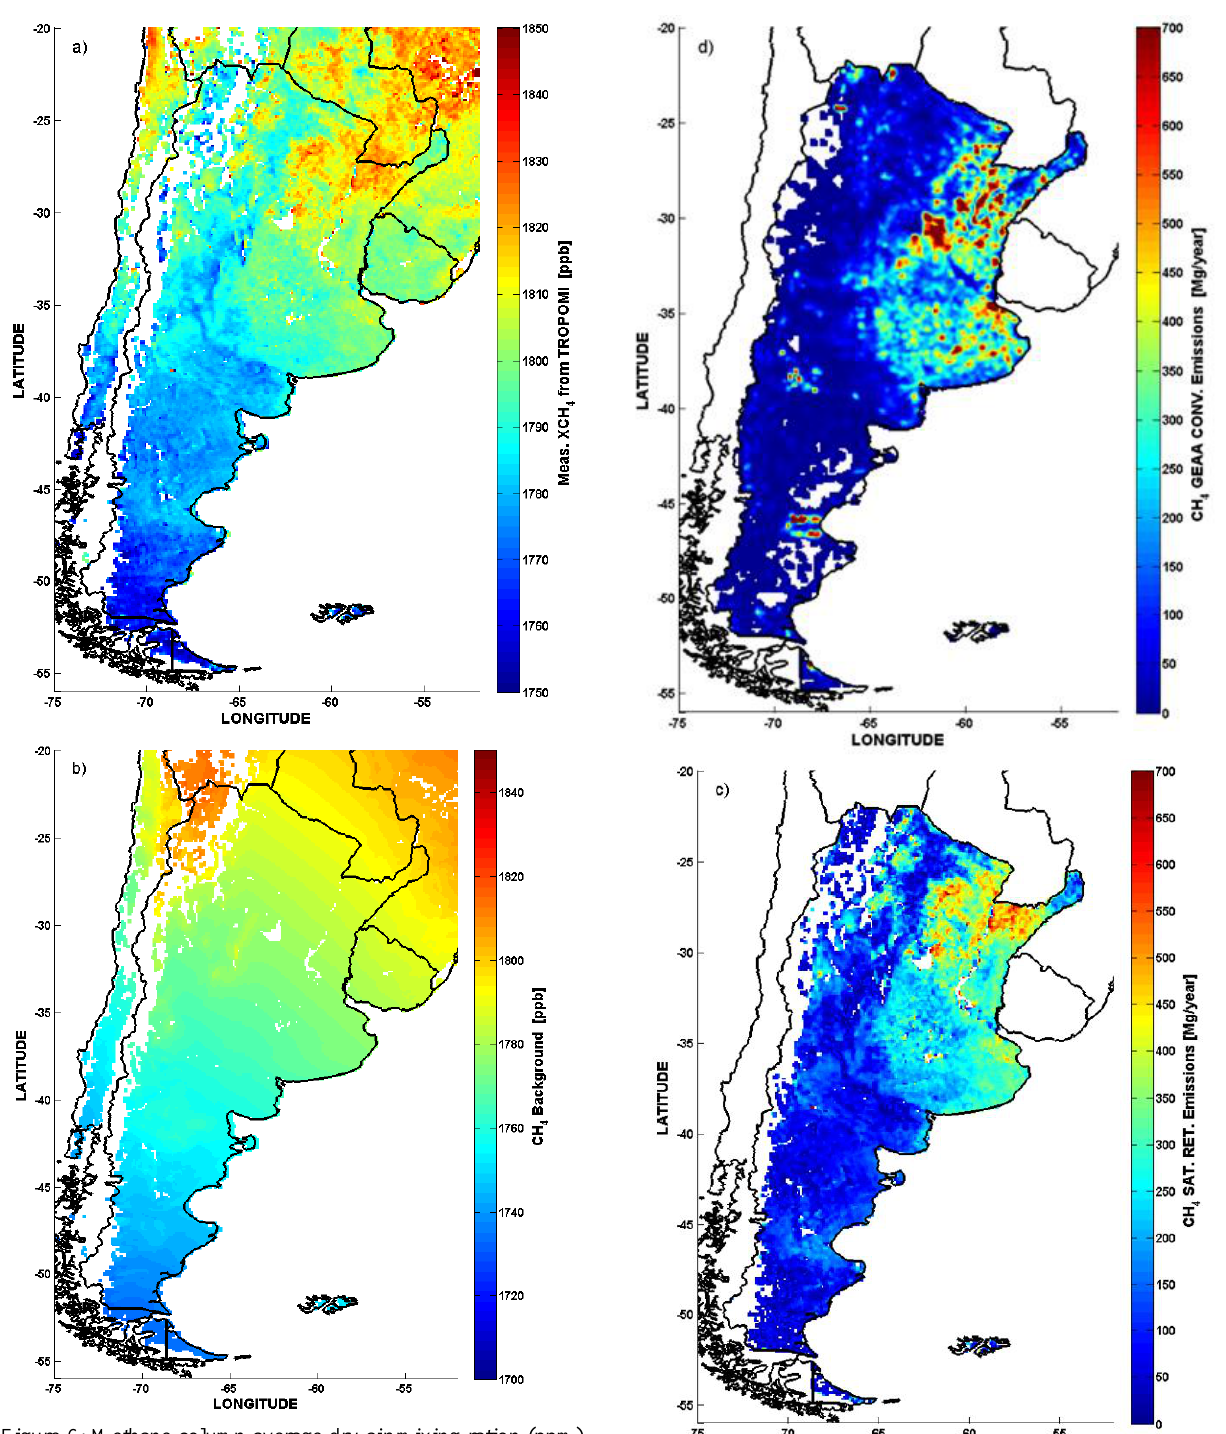
Figure 6: Methane column average dry air mixing ration (ppm) from two satellites for year 2018. a) TROPOMI; b) Estimated background; c) methane enhancement ΔXCH 4 from satellite;